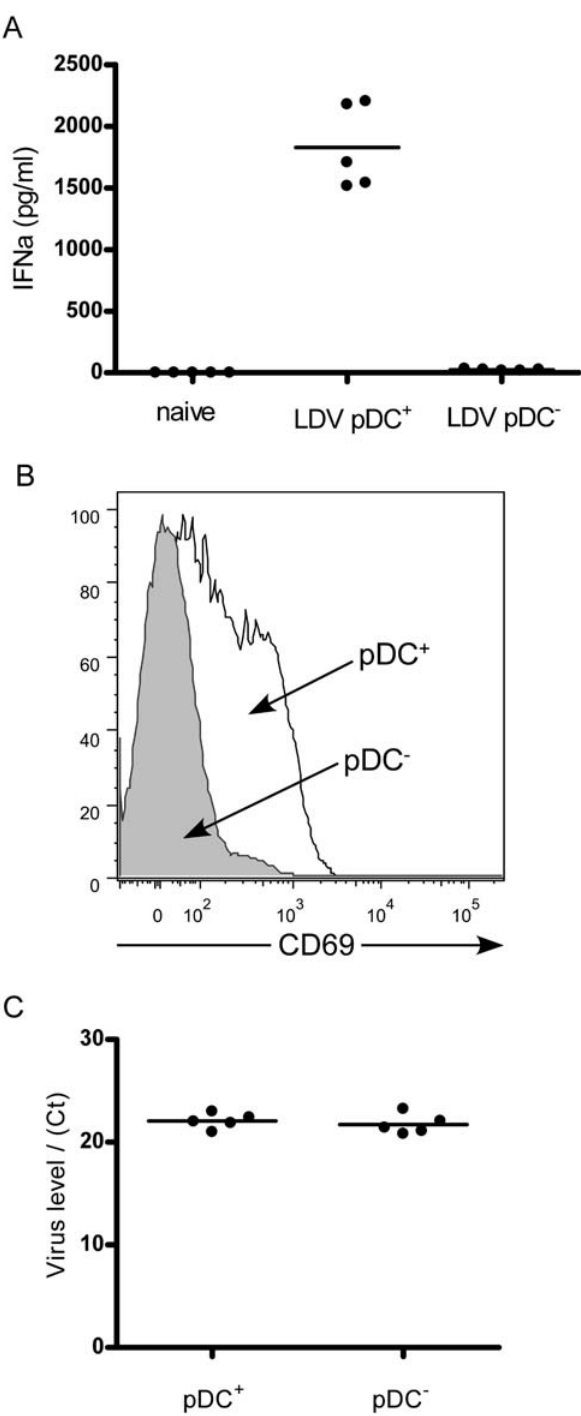
Figure 3. In vivo depletion of plasmacytoid dendritic cells abolishes IFN a production. Naı¨ve (A.BY x B10)F1 mice were depleted of pDC’s by injection of 0.5 mg mPDCA-1 antibody (Miltenyi Biotec) 24 h prior to infection with LDV, and blood samples were collected at 16hpi. (A) Interferon alpha levels in naı¨ve mice (left), LDV- infected normal mice (middle), and LDV-infected, pDC-depleted mice (right) were measured by ELISA (PBL Interferon Source). The difference between the two LDV-infected groups was statistically significant by t test (P , 0.0001, n=5). (B) Flow cytometric analysis of peripheral blood lymphocytes showed significant reductions in LDV-induced expression of CD69 in pDC depleted mice (average mean fluorescence intensity